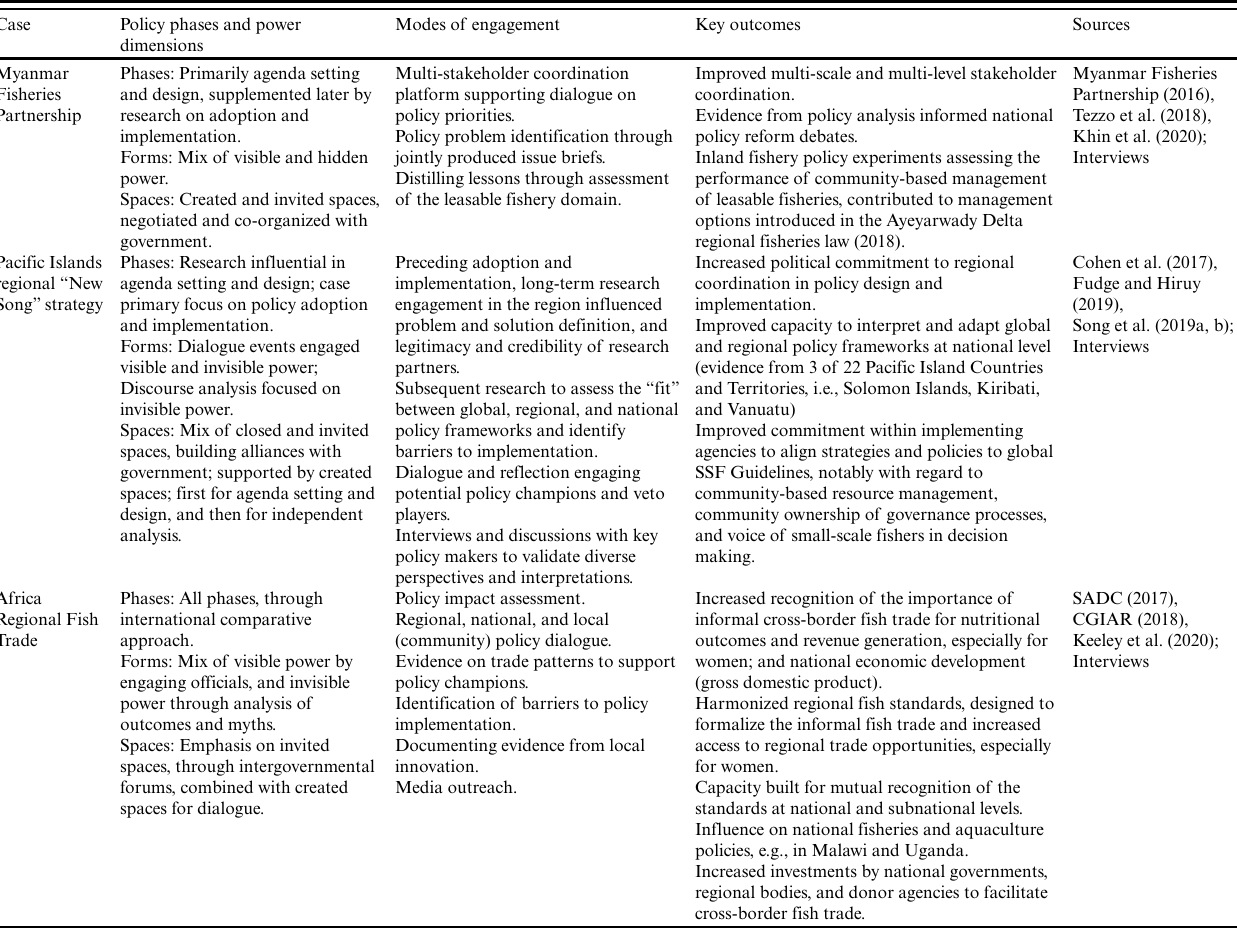
Table 2. Three cases of policy-oriented research engagement in small-scale fisheries (SSF). Each case is summarized in terms of the three dimensions of the framework in Figure